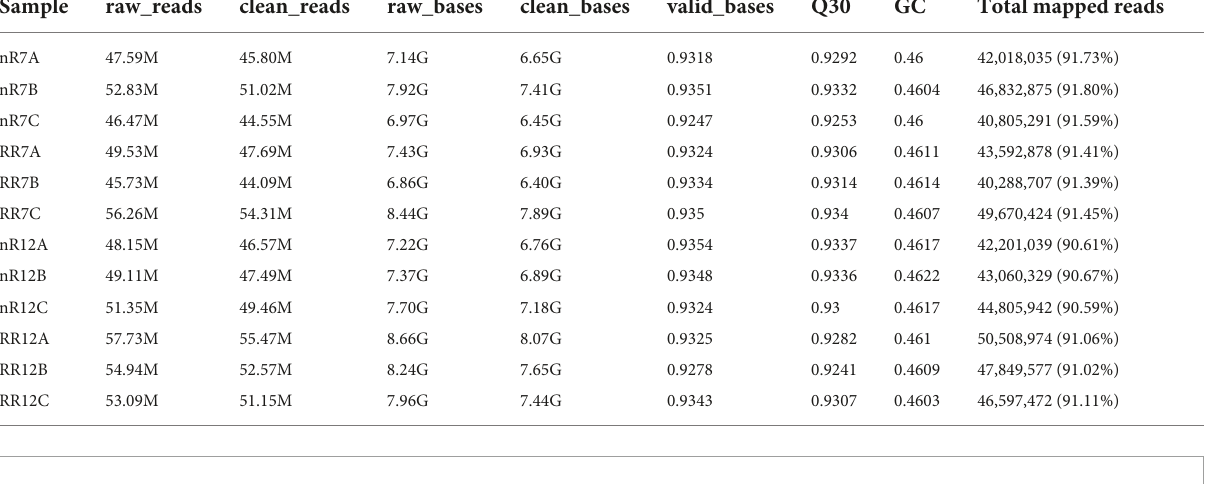
TABLE 1 The statistical information of transcriptome sequencing.